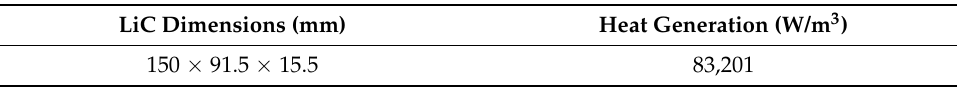
Figure 4. The power loss of the LiC single cell under fast charge and discharge with continuous 150 A current rate during the 3000 s experimental test. Table 2. The generated heat of the LiC cell, in regard to its dimensions for the continuous 150 A current